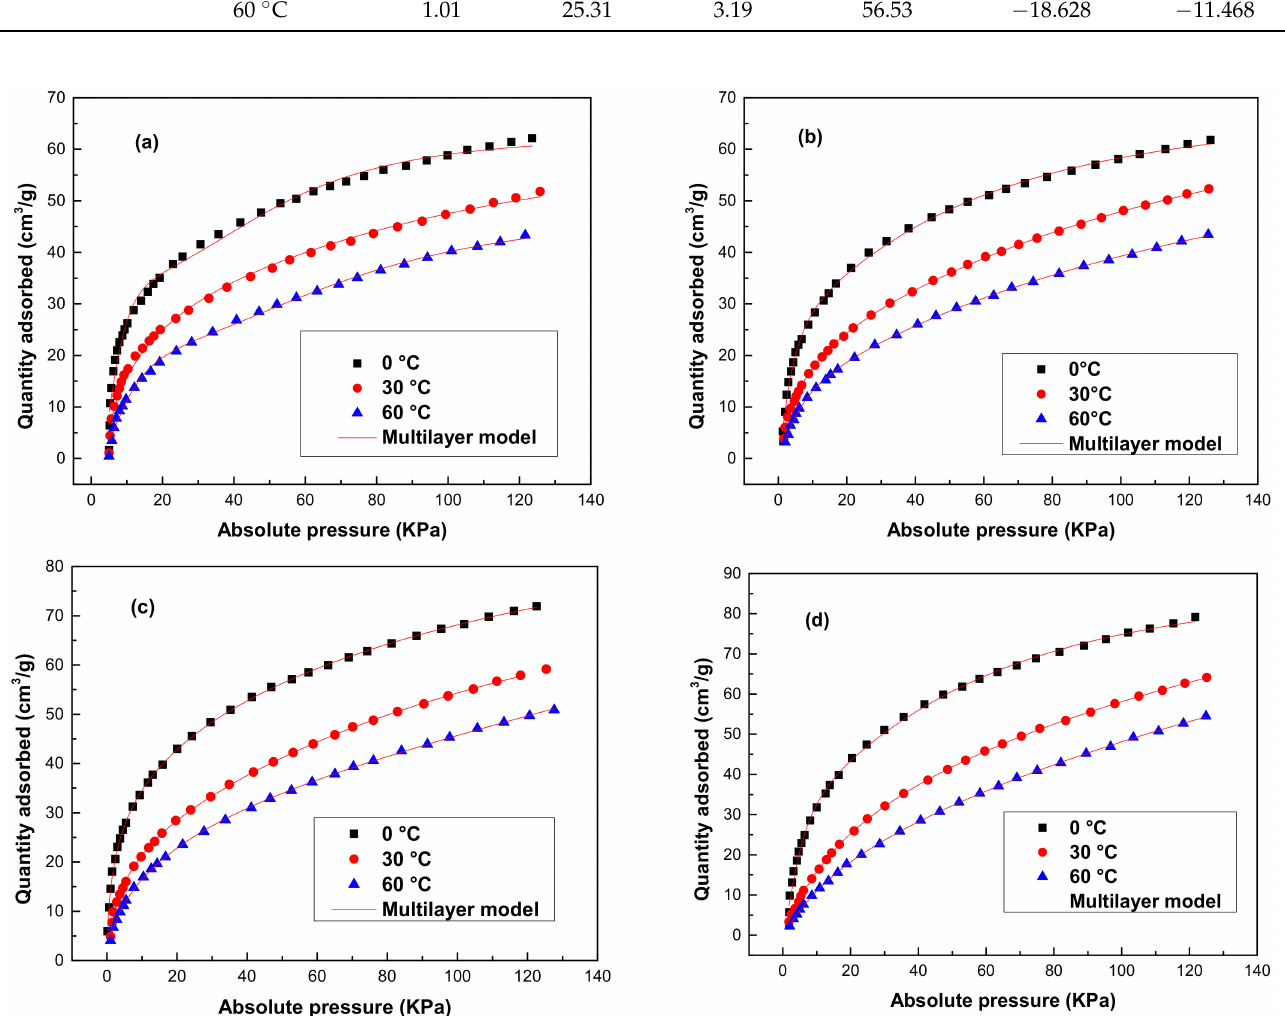
Figure 4. Experimental adsorption isotherms of CO 2 on ( a ) Na-ZSM-5, ( b ) Mg-ZSM-5, ( c ) La-ZSM-5 and ( d ) Zn-ZSM-5 at three temperature and fitting by multilayer statistical physics model